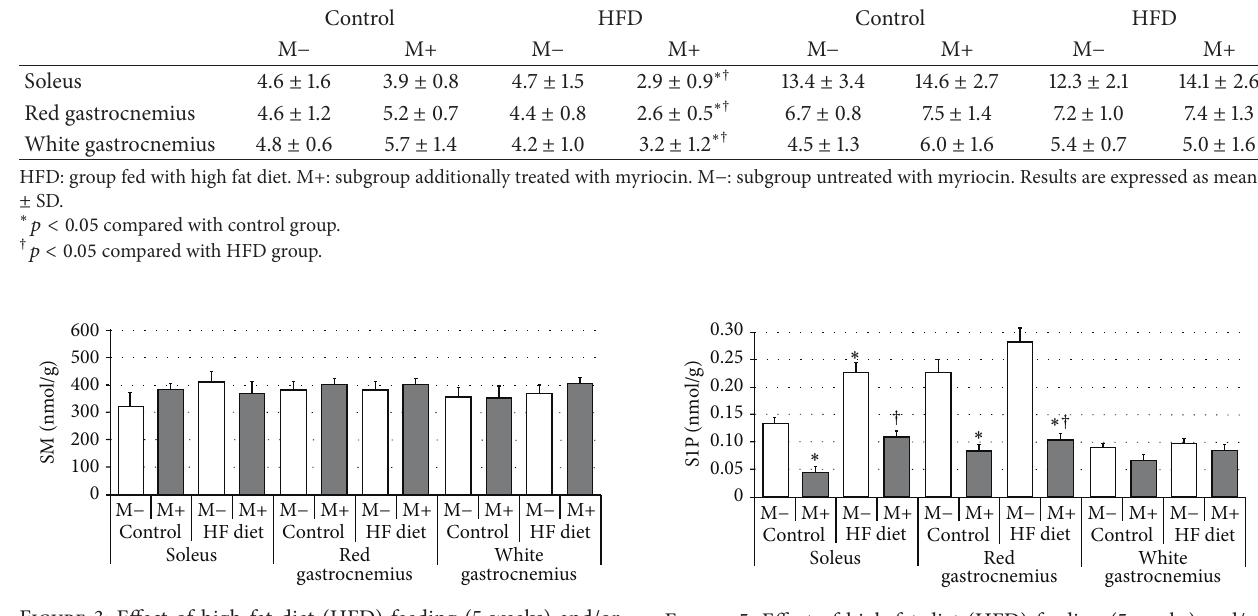
Figure 5: Effect of high-fat diet (HFD) feeding (5 weeks) and/or myriocin application (7 days) on sphingosine-1-phosphate (S1P) content in skeletal muscles ( 𝑛 (per group) = 8). M+: rats adminis- tered with myriocin. M − : untreated group. Results are expressed as means ± SD. ∗ 𝑝 < 0.05 compared with control group. † 𝑝 < 0.05 compared with HF diet group.